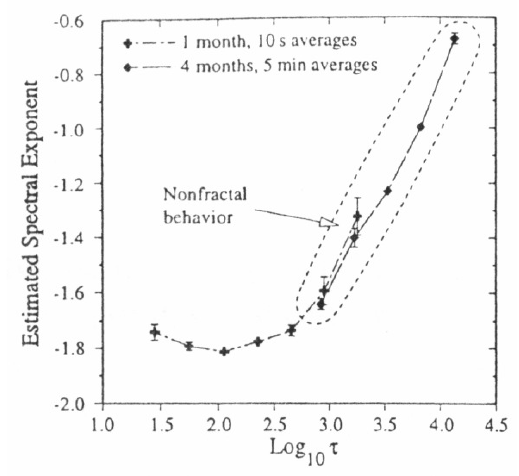
Figure 55: Spectral exponents for the 𝐵 𝑧 component estimated from the length function computed from Ulysses magnetic field data, when the s/c was at about 4 AU and ∼ − 50 ∘ latitude. Different symbols refer to different time intervals as reported in the graph. Image reproduced by permission from (from Horbury et al. ,